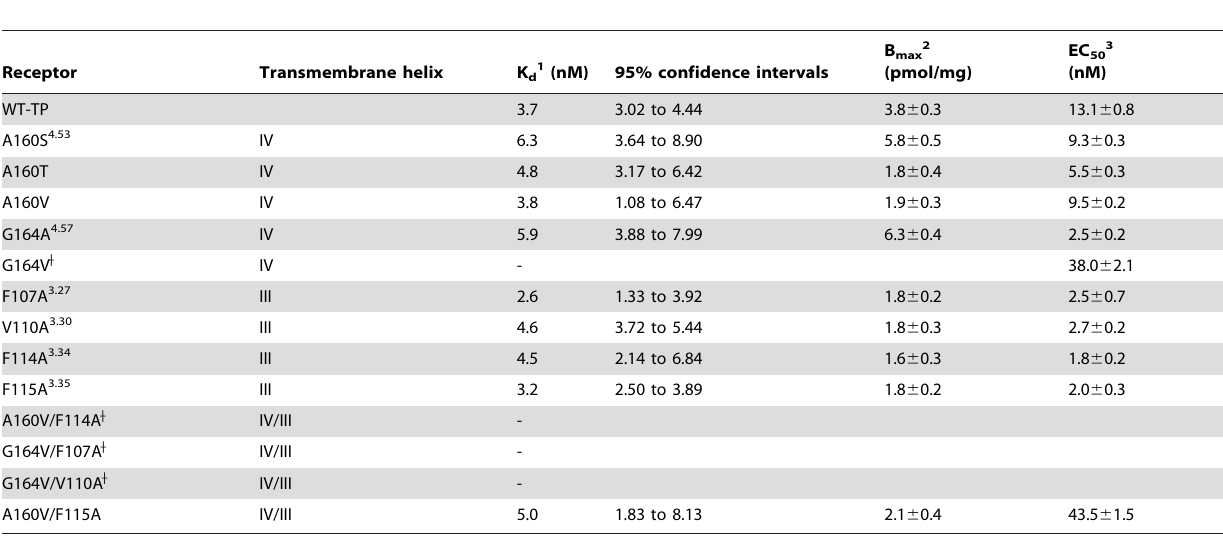
Table 1. Summary of ligand binding properties of wild type TP and